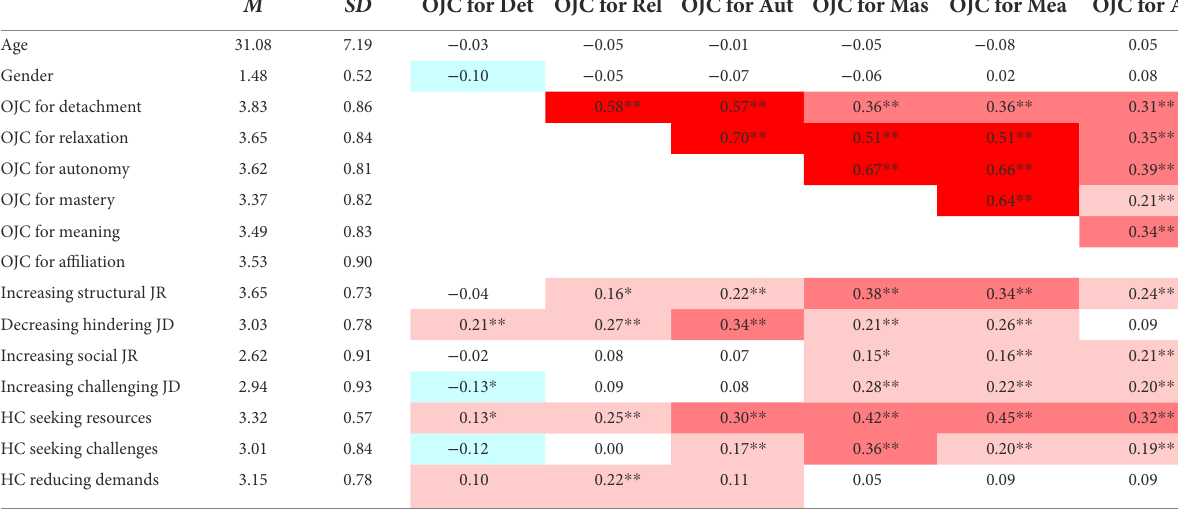
TABLE 8 Correlations of the OJC dimensions, job crafting and home crafting, Study 5. M SD OJC for Det OJC for Rel OJC for Aut OJC for Mas OJC for Mea OJC for Aff